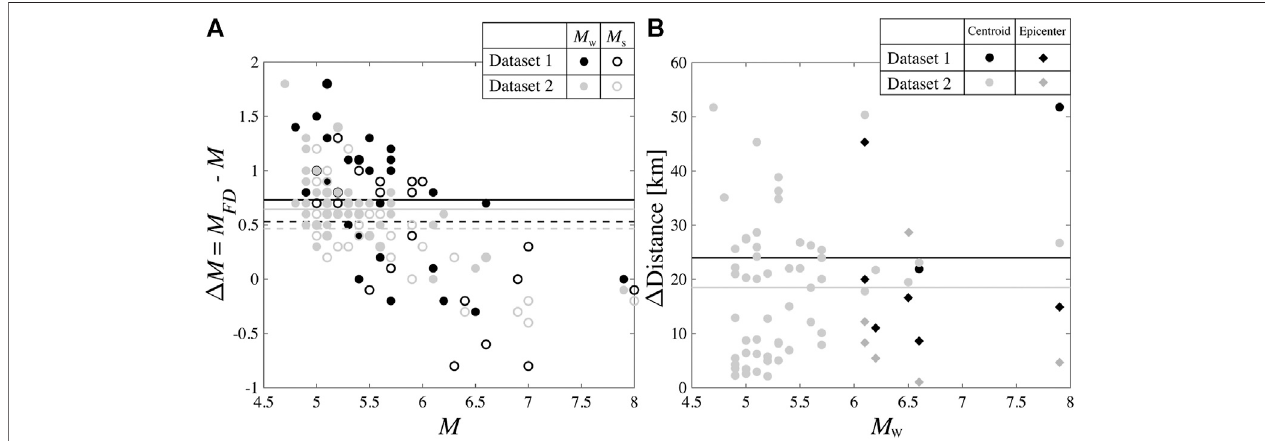
FIGURE8|(A) Differencebetweenthe fi nalFinDerestimatedmagnitude, M FD ,andthereported M W / M S . (B) Distancebetweentheestimated fi nalepicenter(for M W ≥ 6 only)/centroid (for all events) and the reported epicenter/centroid. The solid and dashed lines show the average values for M W and M S for dataset 1 (black) and dataset 2 (gray), respectively.